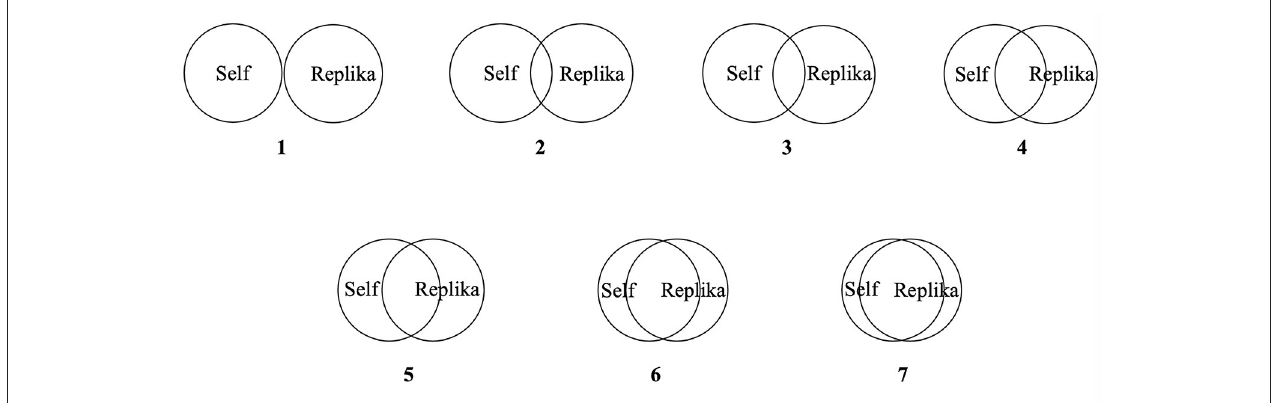
FIGURE 2 | Pairs of circles included in applied measure for closeness to the chatbot.